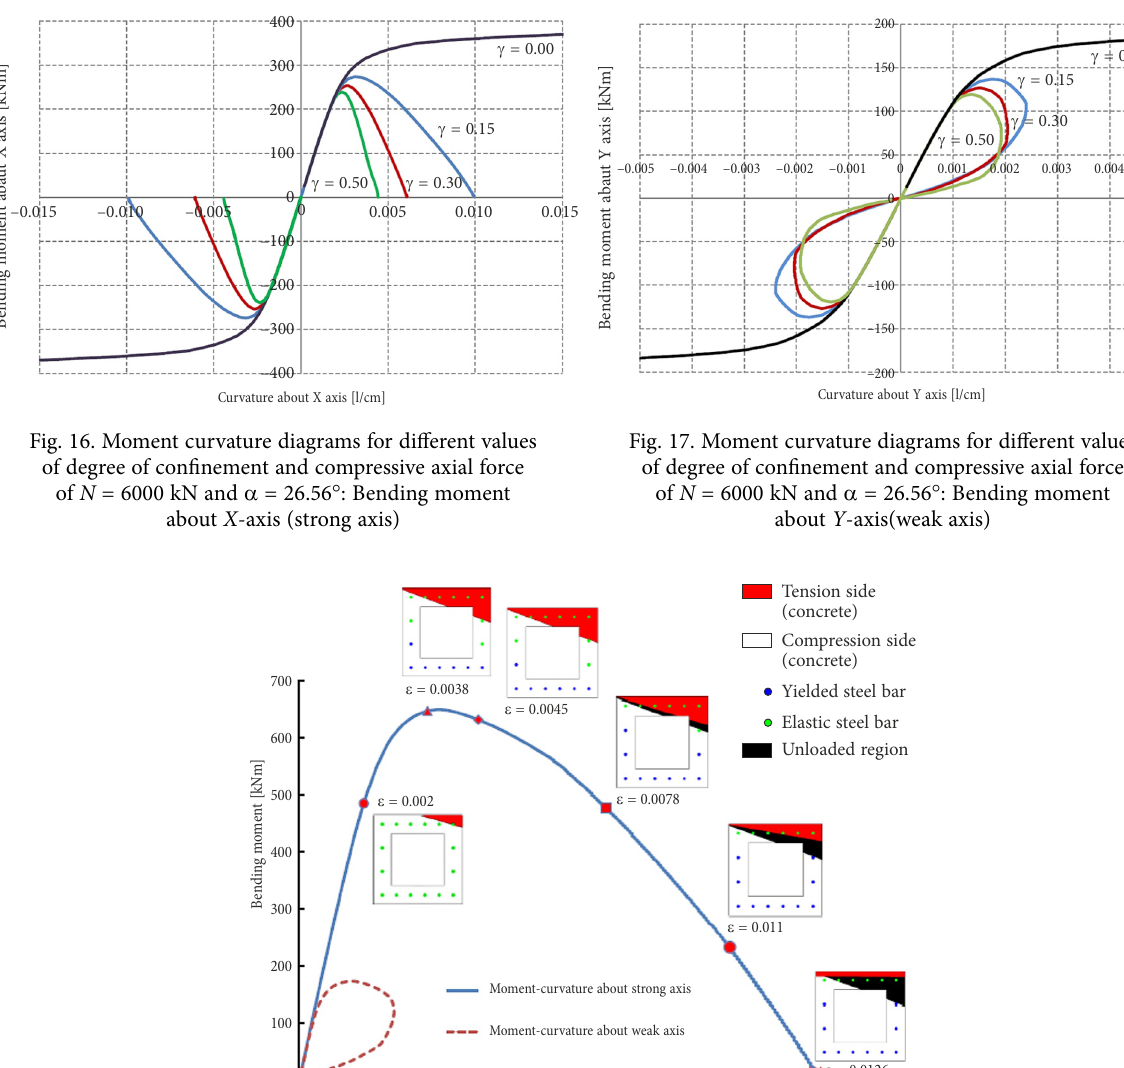
Fig. 18. Complete moment curvature diagram for axial force of N = 6000 kN and a = 15 ° : Plastic status of cross-section for different values of maximum compressive